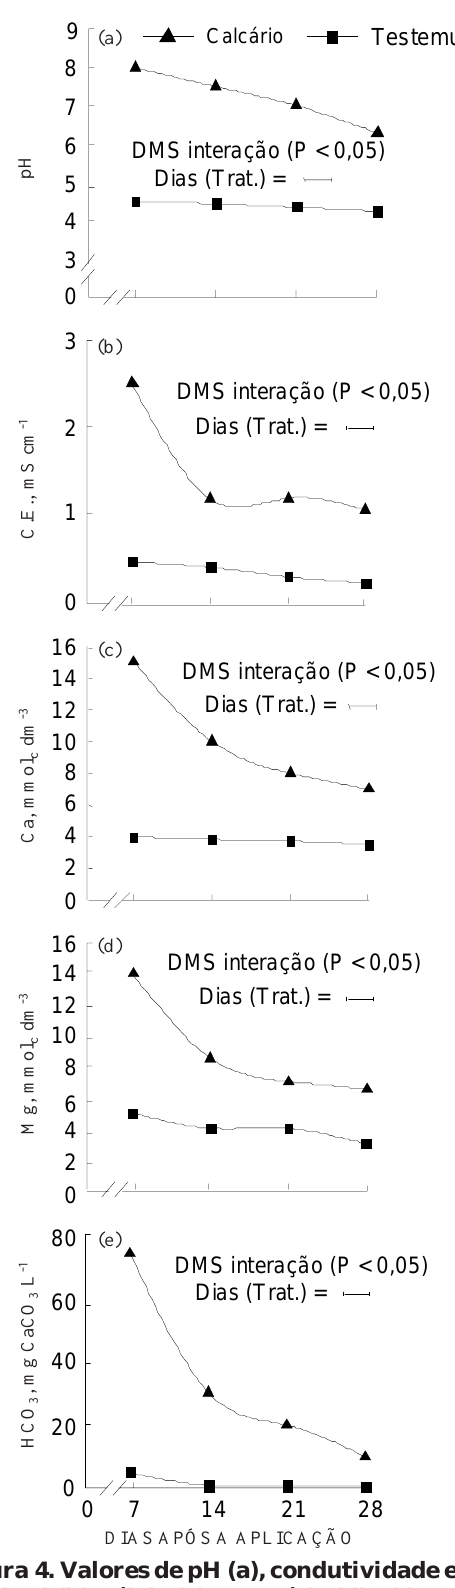
Figura 4. Valores de pH (a), condutividade elétrica (CE) (b), cálcio (c), magnésio (d) e bicarbonato (e) da solução percolada de acordo com as épocas de adição de água sobre o solo com e sem calcário